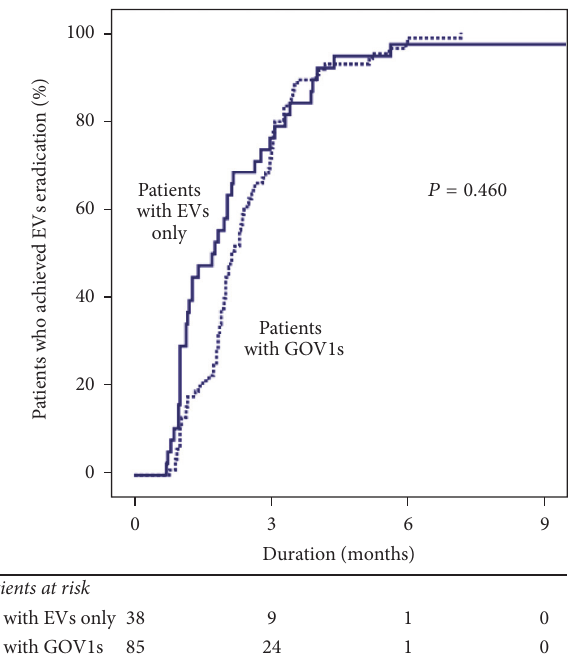
Figure 2: Cumulative incidence for eradication of esophageal varices by endoscopic band ligation—arranged according to the type of varices at baseline. EVs: esophageal varices; GOVs: gastroe- sophageal